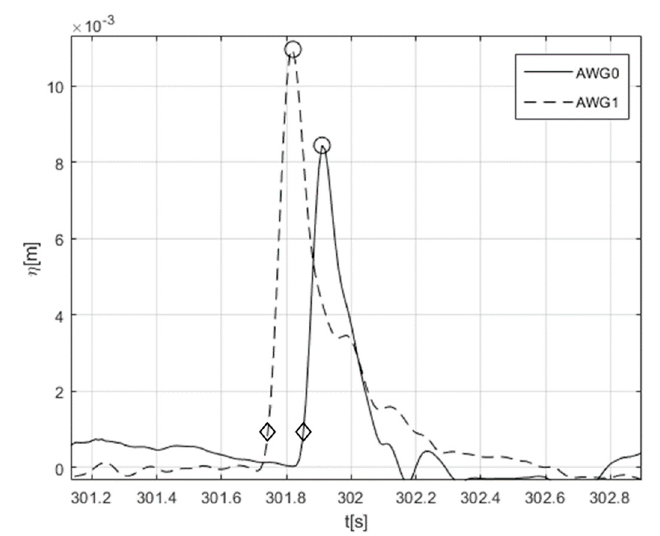
Figure 6. Example of simultaneous time series recorded by ultrasonic sensors.